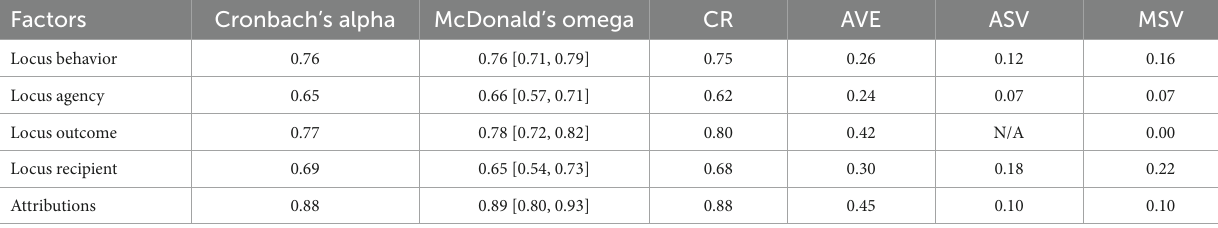
TABLE 3 Validity measures of Model 3 for all scales from the